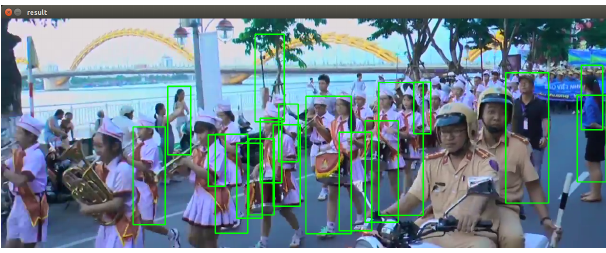
Figure 7. Vehicle Counting process